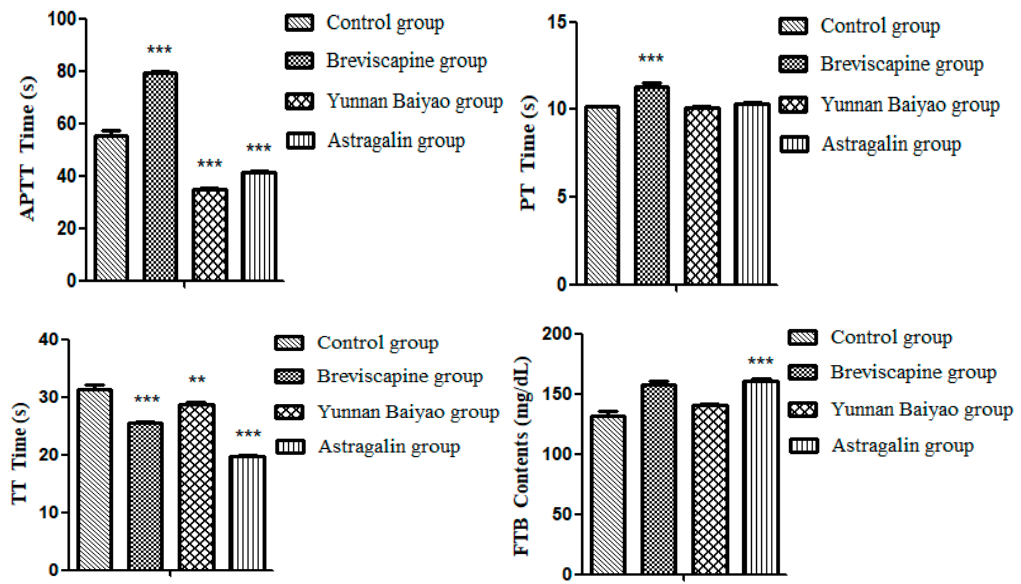
Figure 1. Results of the coagulation four indices of samples (X ± SD, n = 3). Compared with the control group: *** p < 0.001, ** p < 0.01.